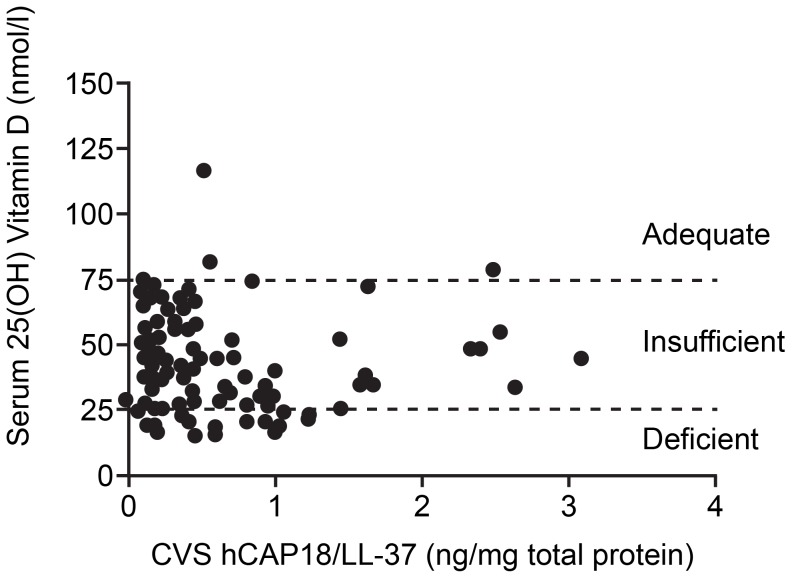
Relationship between 25(OH) vitamin D and hCAP18/LL37 in endocervical (END E6/E7) and ectocervical (ECT E6/E7) cell lines.Correlation between serum 25(OH) vitamin D and CVS hCAP18/LL-37 (r = −0.13; n = 122; p = 0.14). Data presented as scatter plots and divided in to deficient <25 nmol/l, insufficient 25–75 nmol/l and adequate >75 nmol/l. Data analysed by Pearson's Correlation.